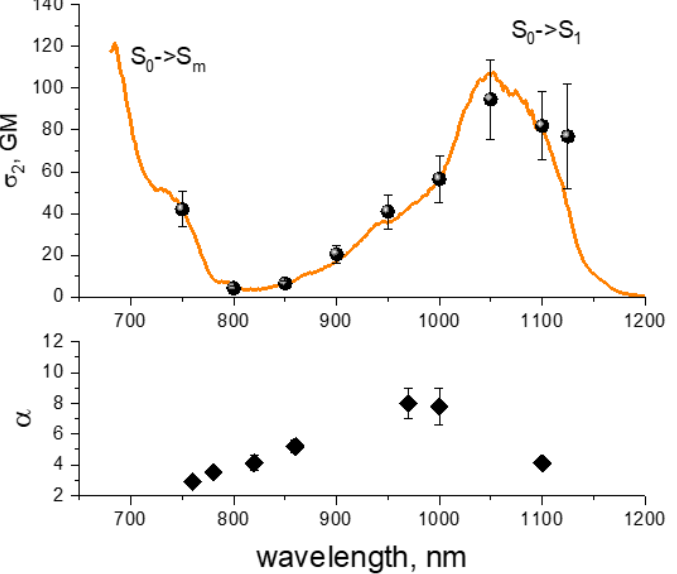
Figure 8. Top: Two-photon absorption spectrum of tdTomato in purified buffer solution at pH8, (orange line) [11] and two-photon excitation spectrum of tdTomato measured in E. coli cells (symbols) (normalized to the 2PA cross section of solution spectrum at 750 nm). Bottom: Power exponent α of the dependence of photobleaching rate on laser power (see text for details).